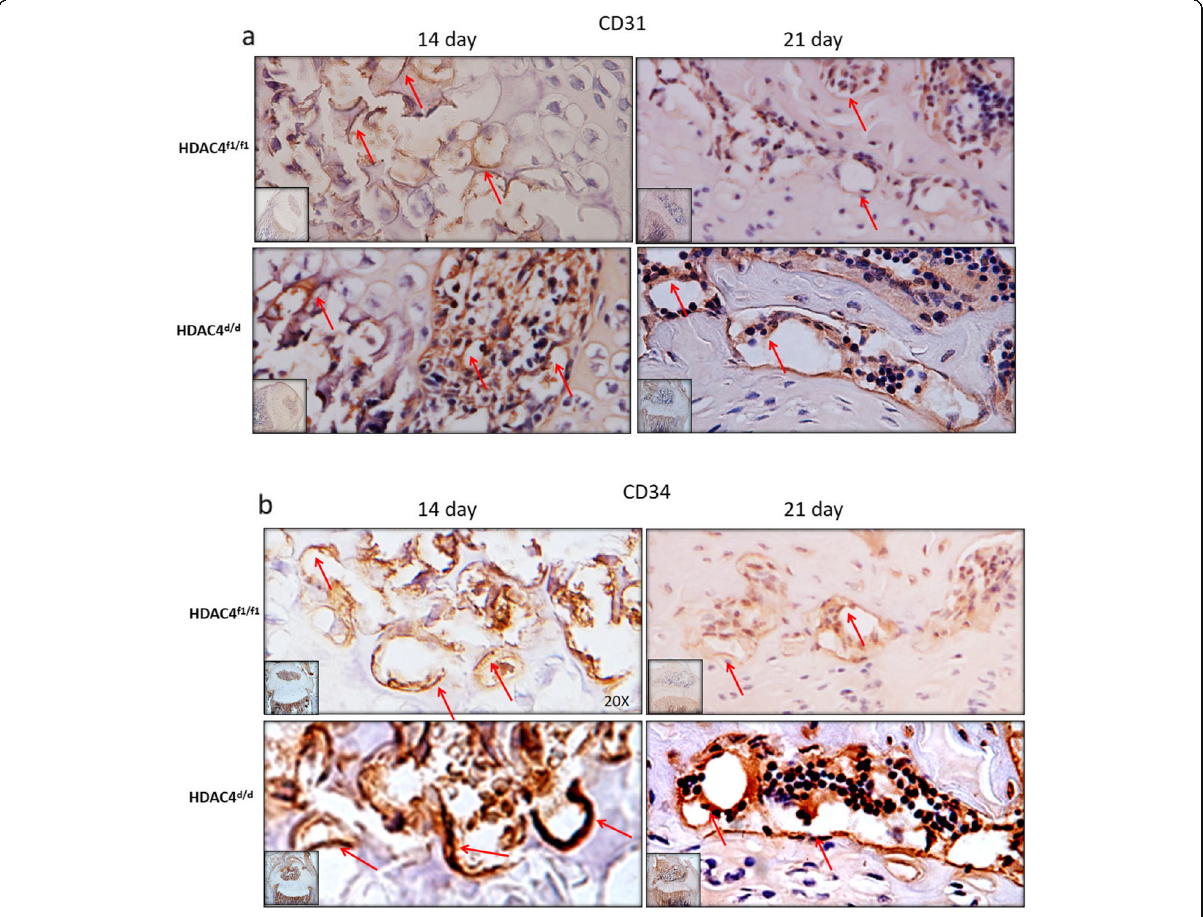
Fig. 3 Increased expression of CD31 and CD34 in Col2 α 1-Cre; HDAC4 d/d mice. Strong staining of CD31 ( a ) and CD34 ( b ) was observed in knee joint tissue sections from Col2 α 1-Cre ; HDAC4 d/d mice compared with knee joint sections from control animals on postnatal days 14 and 21. The red arrow indicates the newly formed